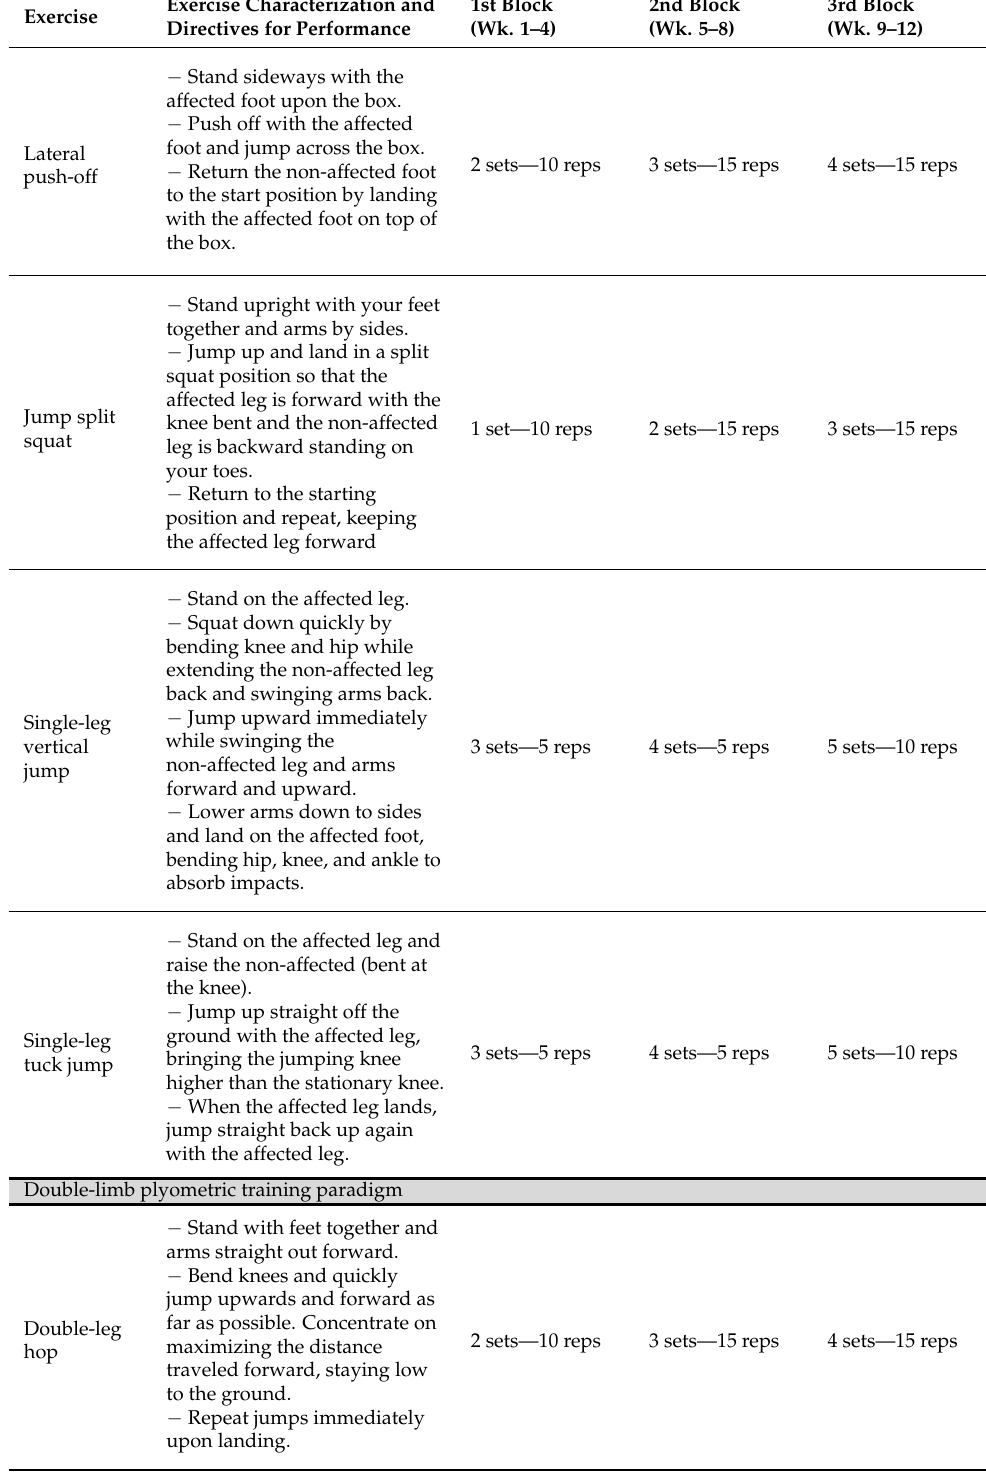
Table 1. Cont. Exercise Characterization and Exercise Directives for